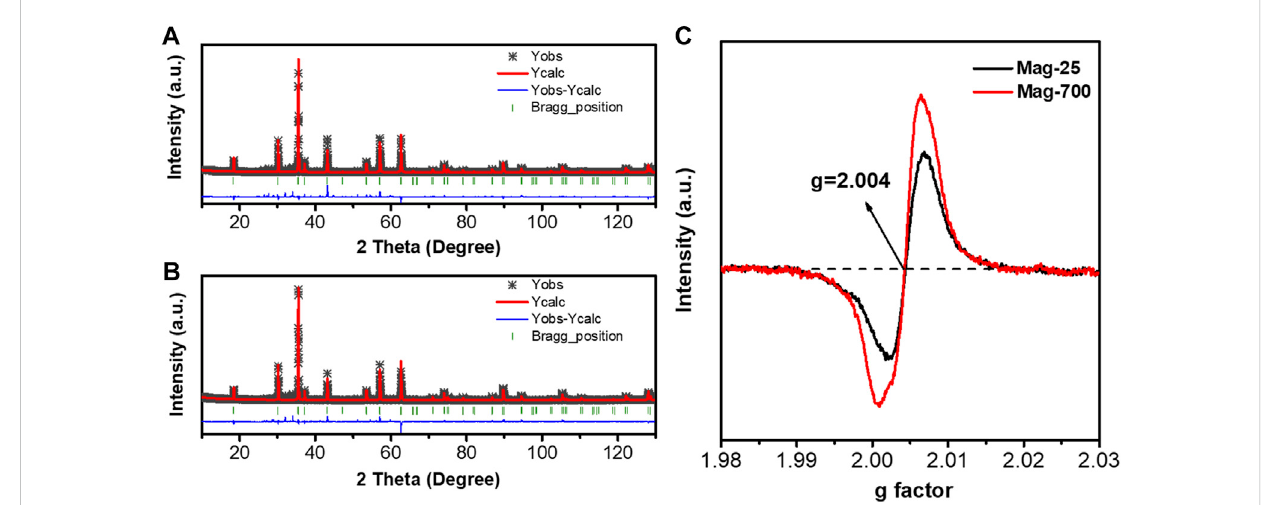
FIGURE 5 Rietveld re fi nement of the XRD patterns for (A) Mag-25; (B) Mag-700 and EPR spectra measured at room temperature (C) .